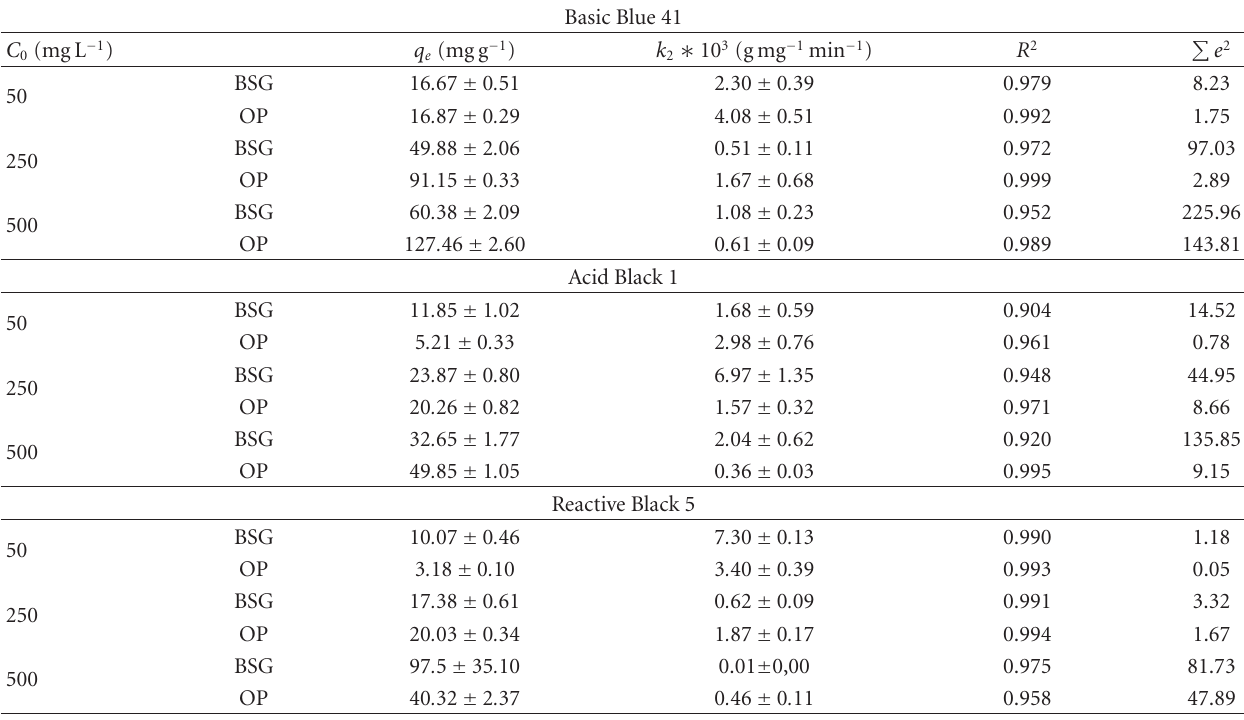
Table 5: Parameters of pseudo second order